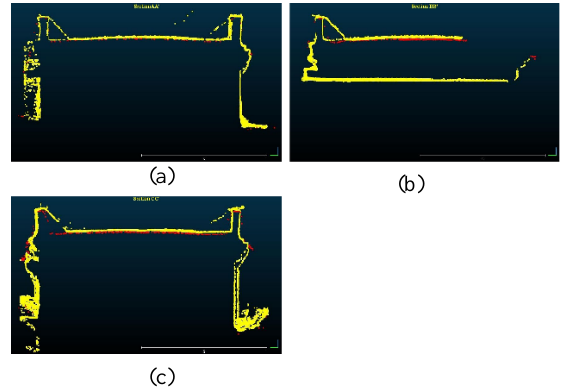
Figure 9. Comparisons of the cross-sections of AL (red) and ML (yellow) for sections: (a) AA'; (b) BB'; (c) CC’.